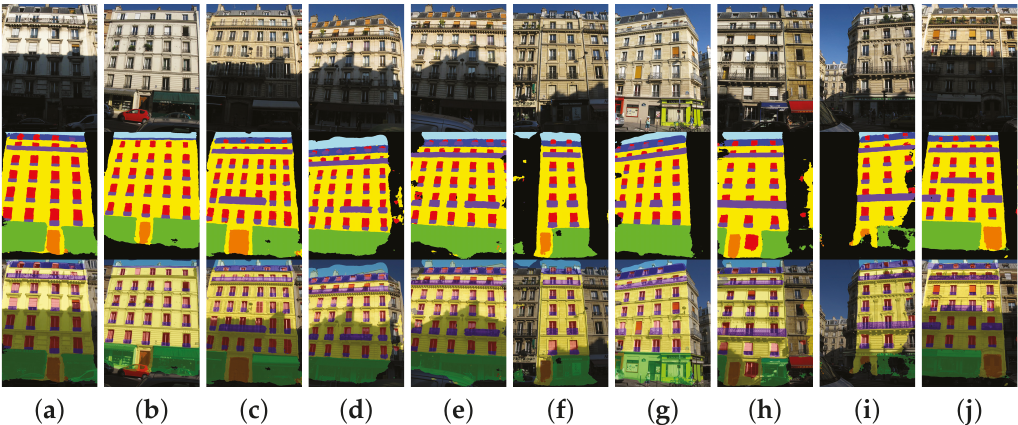
Figure 5. Results over the RueMonge2014 dataset. The rows are split into: original, segmented image and both, respectively. These segmented images are the inferences made under the evaluation sets only. ( a – j ) Example of RueMonge2014 images, segmented by the neural model presented in Section 4.1.2. In the first line, the original image, the second line, the result of the inference (segmentation), and the third and last line, the overlapping